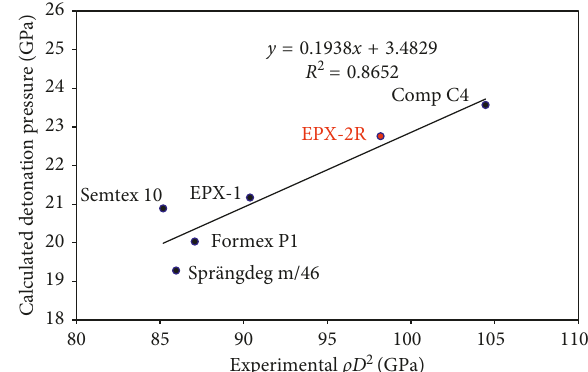
Figure 4: A relationship of the detonation pressure (calculated) and the experimental ρD 2 .